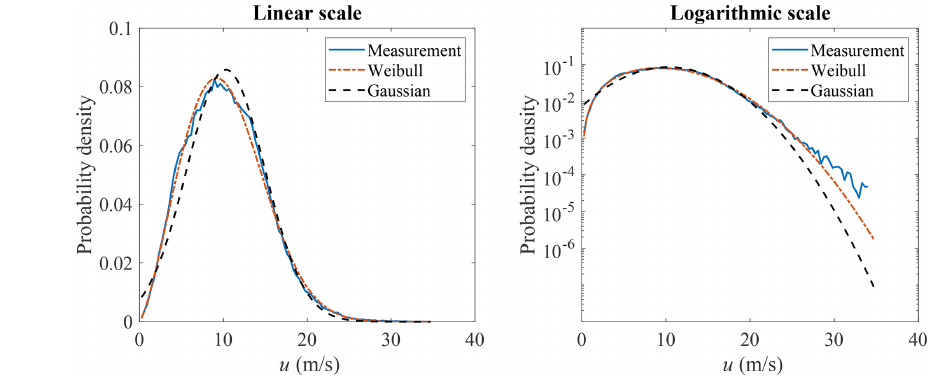
Figure 4. Marginal distribution of u with Weibull fitting.